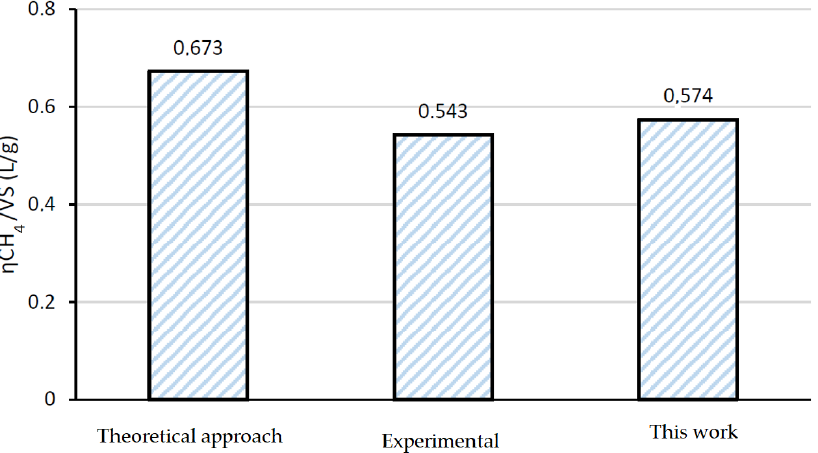
Figure 1. Model validation with a theoretical approach [43] and experimental [26] results.